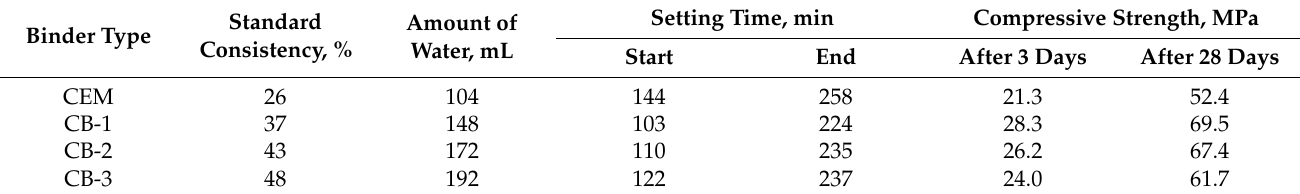
Table 4. Results of compressive strength tests of sample cubes made of Portland cement and ground composite binders. Binder Type Standard Consistency, % Amount of Water, mL